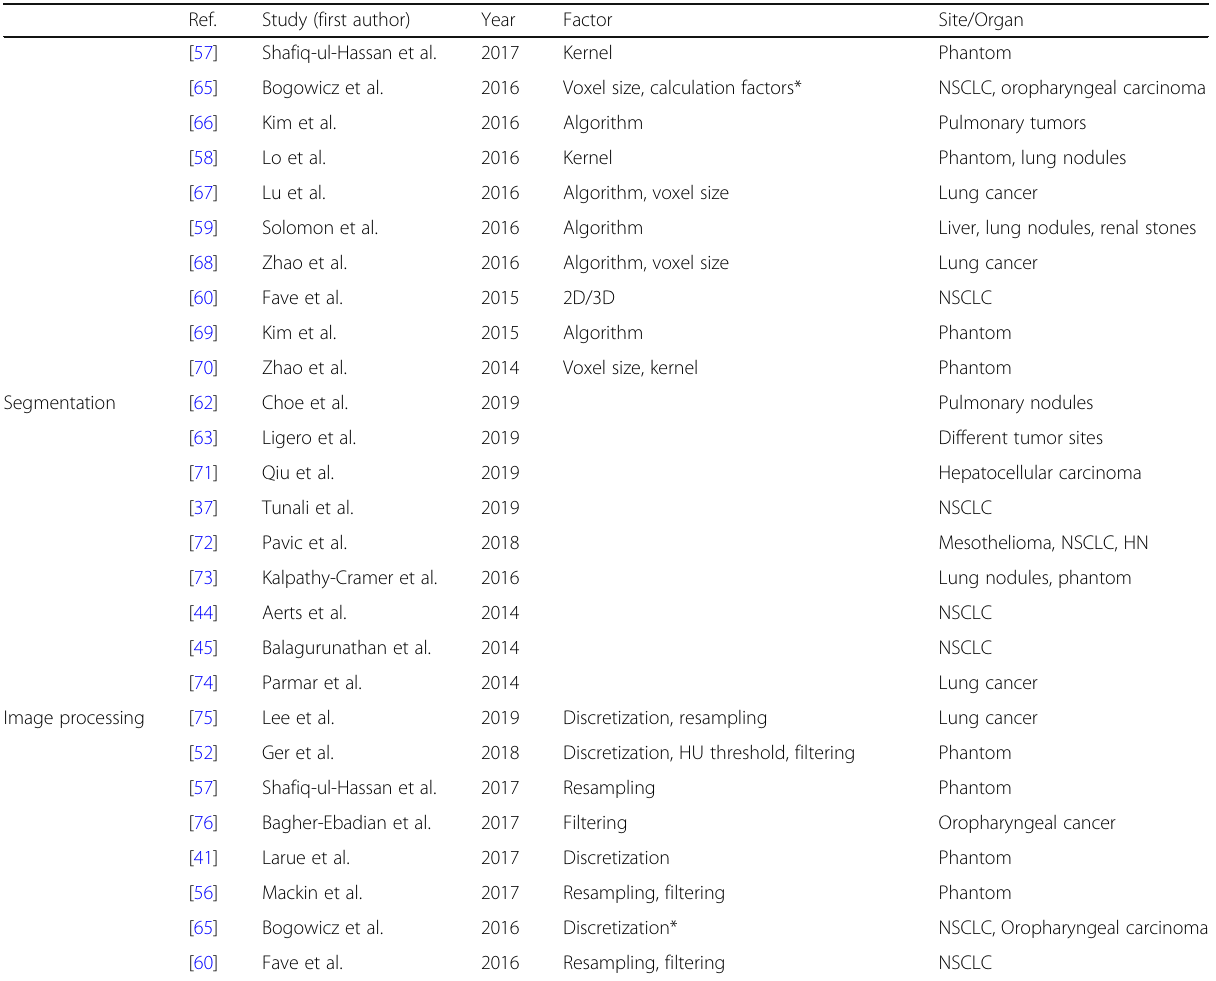
Table 1 Literature review for oncologic imaging or phantom studies with computed tomography (Continued)